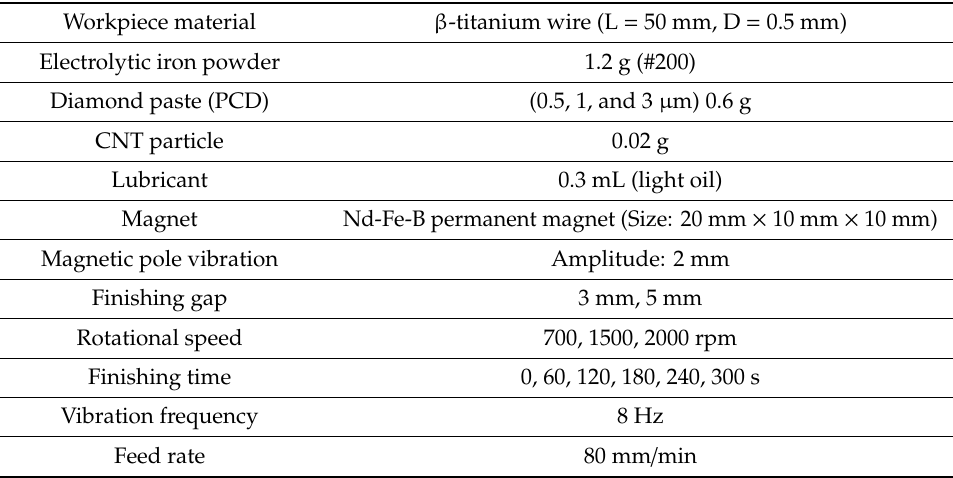
Table 3. Experimental